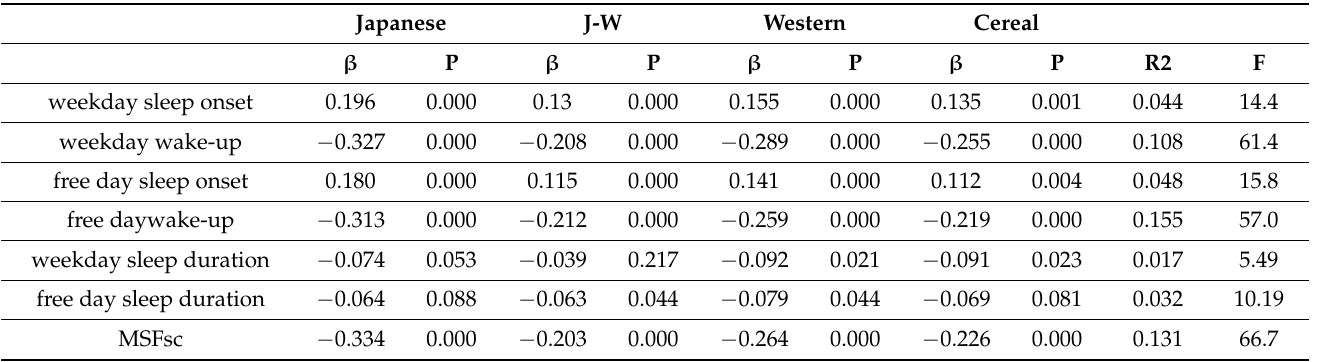
Table 3. Multivariate linear regression analysis for interaction between sleep parameters and breakfast meal